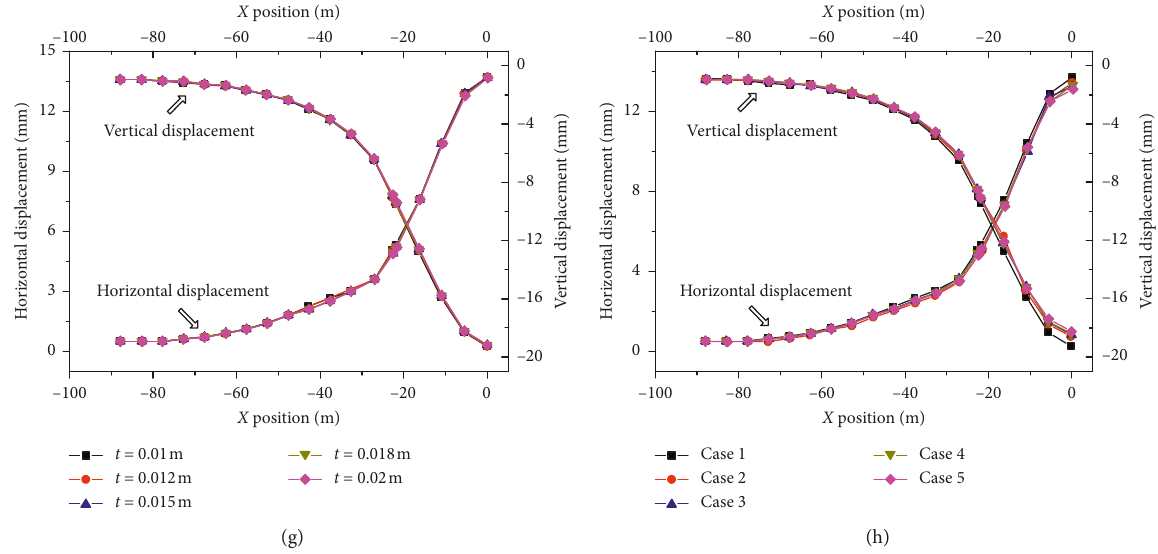
Figure 9: (a) Pipeline displacements on excavating process. (b) Pipeline displacements with different soil properties around the pipeline. (c) Pipeline displacements with different distances away from pit. (d) Pipeline displacements with different pipeline burial depths. (e) Pipeline displacements with different pipeline properties. (f) Pipeline displacements with different pipeline outer diameters. (g) Pipeline dis- placements with different pipeline thicknesses. (h) Pipeline displacements with the coexistence of